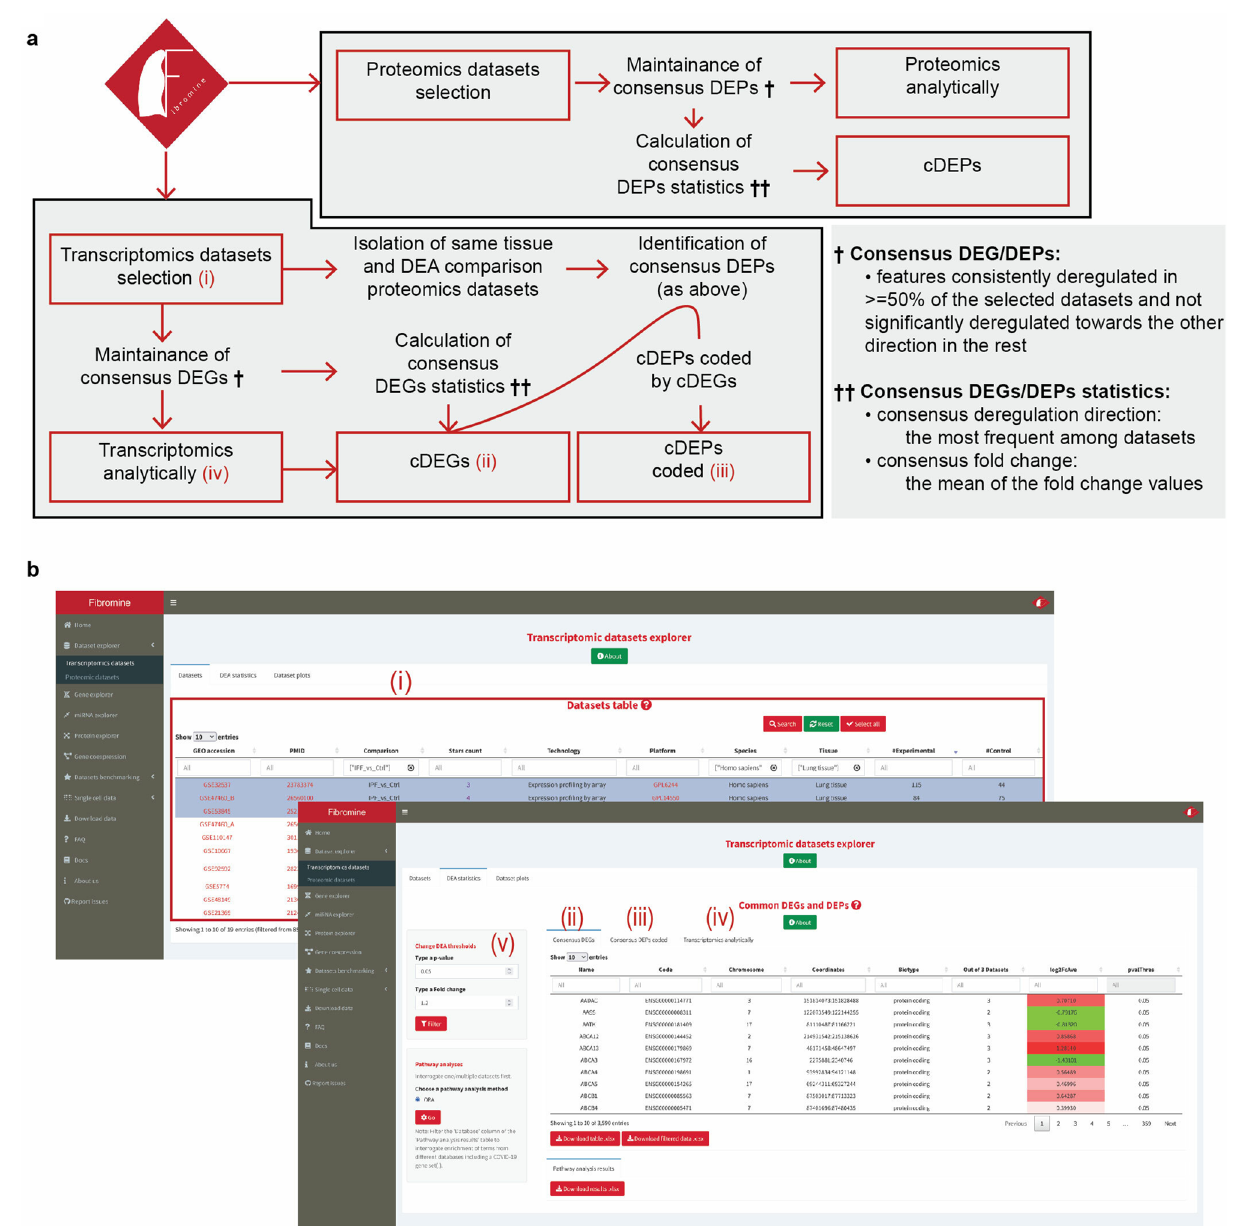
Figure 3. Same species datasets integration workflow. (a) Dataset explorer same species transcriptomic/ proteomic datasets integration workflow. Boxes of red correspond to front-end elements, while the rest account for back-end processes. Latin number elements are presented in (b) . (b) Front end steps of transcriptomic datasets integration through Dataset explorer : (i) datasets selection, (ii) consensus DEGs table, (iii) consensus DEPs coded by any of the consensus DEGs and sharing the same direction of deregulation, (iv) analytical statistics table. Differential expression default parameters can be changed via a dedicated tuning panel (v). lof2FcAve column of (ii) holds the consensus direction of deregulation for each of the reported genes in a color coded fashion. Out of … Datasets column of the same table enables further tuning of consensus features identification procedure. cDEGs: consensus differentially expressed genes, cDEPs: consensus differentially expressed proteins. Figure was created using https:// www. google. com/ slides/